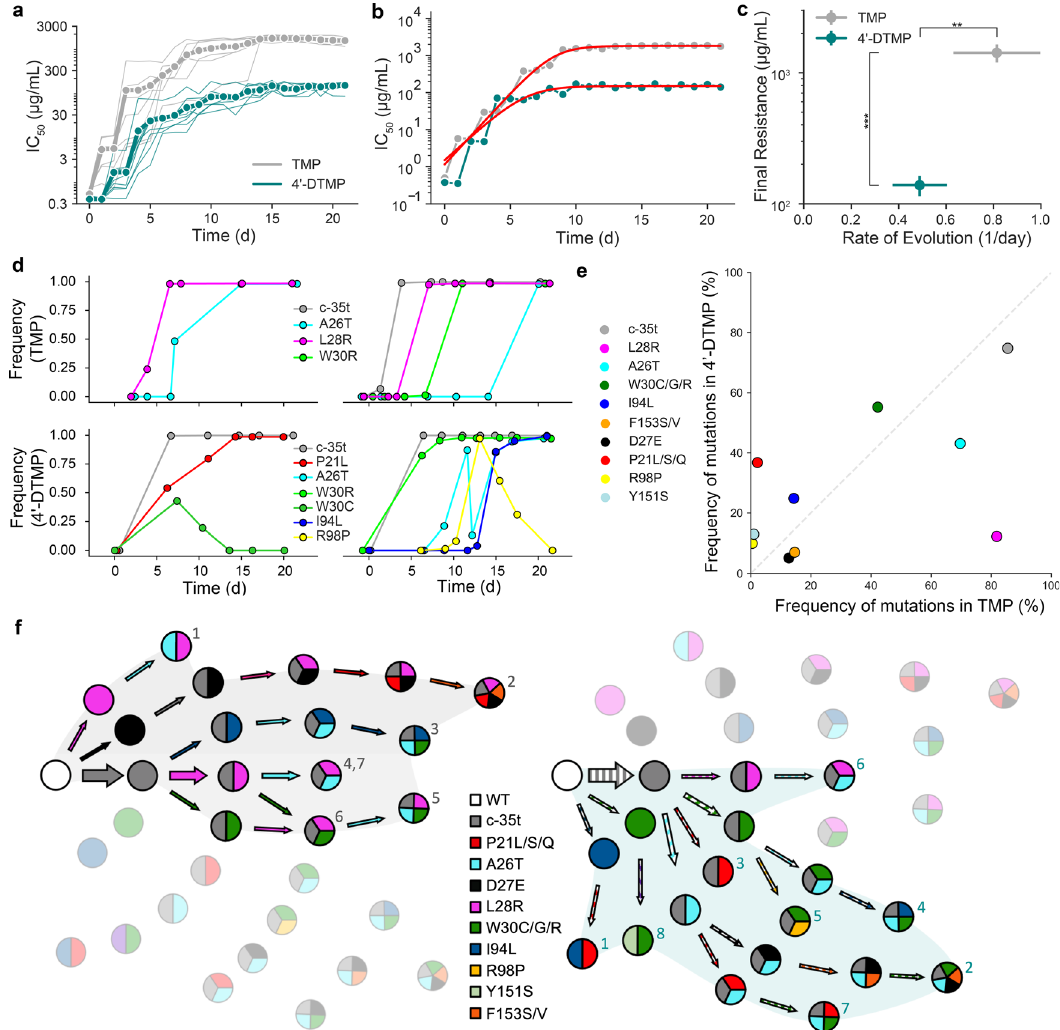
Fig. 4 L28R-speci fi c 4 ′ -DTMP slows down evolution of antibiotic resistance in the morbidostat. a Overlaid changes in resistance levels (IC 50 ) over time for E. coli populations evolved in parallel under inhibition by 4 ′ -DTMP (teal, n = 8 replicates) and TMP (gray, n = 7 replicates), demonstrating an increase in resistance by ~100-fold and ~2000-fold, respectively. Day 0 corresponds to parent strain. Light lines represent individual cultures; dark lines with fi lled circles represent mean values. b A log-logistic function was used to estimate fi nal resistance levels and rate of evolution for evolved E. coli cultures. Representative example showing log-logistic function fi ts in red lines. c E. coli cultures acquired lower resistance levels ( p = 2.10e − 8 ) at slower rates ( p = 0.0016) when evolved in 4 ′ -DTMP compared to cultures evolved in TMP. Student ’ s t -test (two-tailed) is used to quantify signi fi cance of differences in all panels (* p < 0.05, ** p < 0.01, and *** p < 0.001, error bars show the standard deviation, center of the error bars corresponds to the mean value of the measurements). d , Representative examples of time-resolved changes in DHFR as measured by deep sequencing of the folA gene throughout evolution in the morbidostat (top row for TMP- and bottom row for 4 ′ -DTMP-evolved cultures). E. coli cultures develop TMP resistance by acquiring the L28R mutation (6 out of 7 cultures) whereas E. coli cultures become 4 ′ -DTMP resistant without acquiring L28R (only 1 out of 8 cultures acquired L28R). e Final frequencies of observed resistance-conferring DHFR mutations under TMP and 4 ′ -DTMP selection on day 21 were compared. The frequency of L28R mutation (magenta) was drastically reduced from ~80% (in TMP-evolved group) to less than 15% (4 ′ -DTMP-evolved group). f Observed evolutionary trajectories leading to resistance in E. coli . The observed DHFR mutations are indicated by circles, fi lled with colors. The solid arrows represent the mutations acquired by E. coli evolved under TMP selection (left, gray background) whereas the dashed arrows represent the mutations acquired by E. coli evolved under 4 ′ -DTMP selection (right, teal background). The color of the arrows indicate the speci fi c mutations observed. The width of the arrow corresponds to the observed frequency of that mutation. The number on a circle indicates the culture number (gray for TMP and teal for 4 ′ -DTMP evolved cultures, f